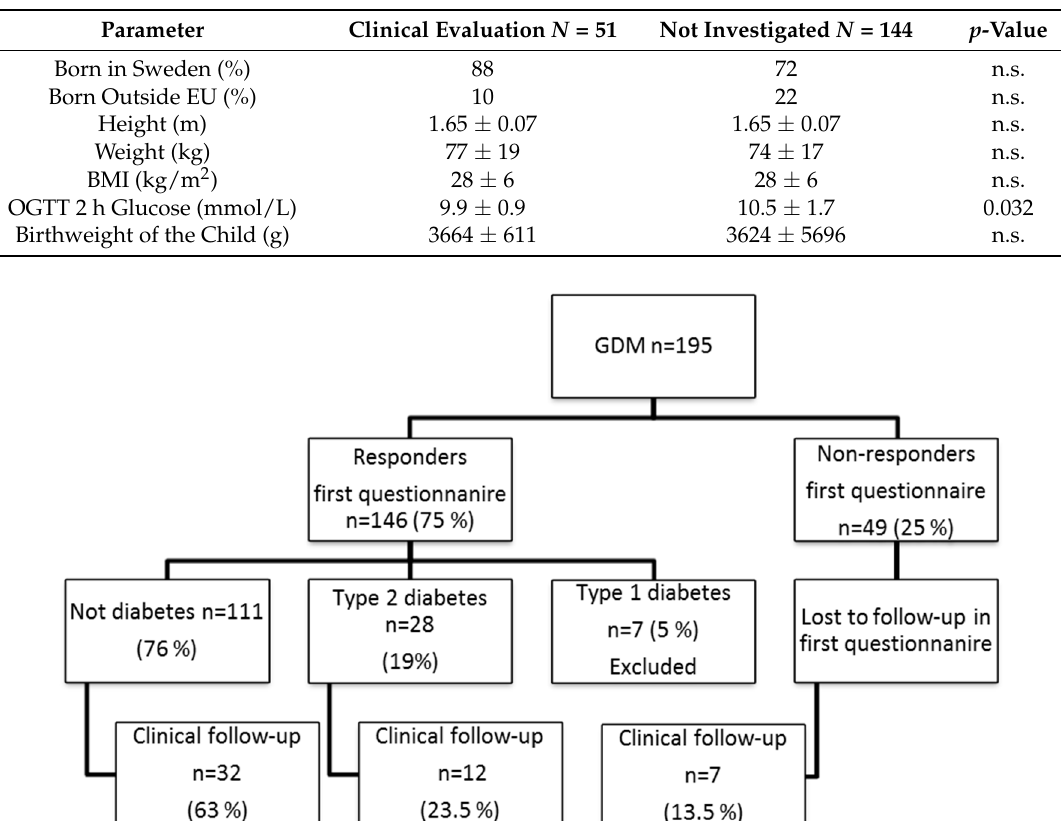
Figure 1. Clinical follow-up cohort, N = 51. Between 1995 and 1999, women with gestational diabetes mellitus (GDM, n = 2025) were reported in a Swedish nationwide study [12]. We identified women ( n = 195) from the cohort living in our regional area of southeast Sweden, near Linköping University Hospital (1 million inhabitants). Of these, the first questionnaire was answered by 146 women (75%).